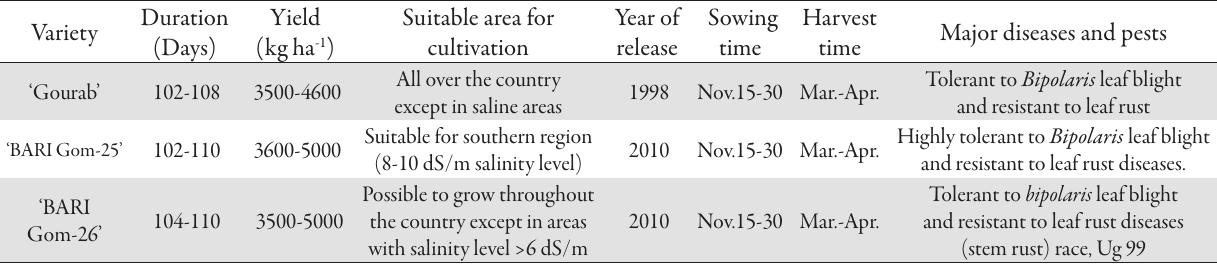
Tab. 2. Characteristics of tested wheat varieties of Bangladesh